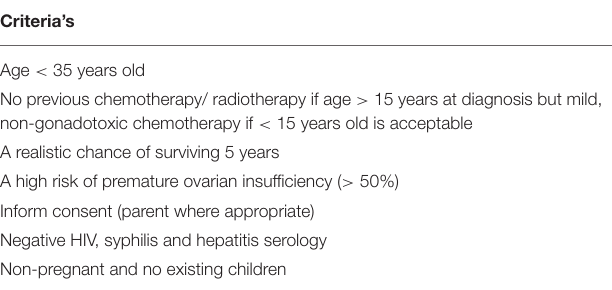
TABLE 2 | The Edinburg criteria for ovarian tissue cryopreservation (1, 11,